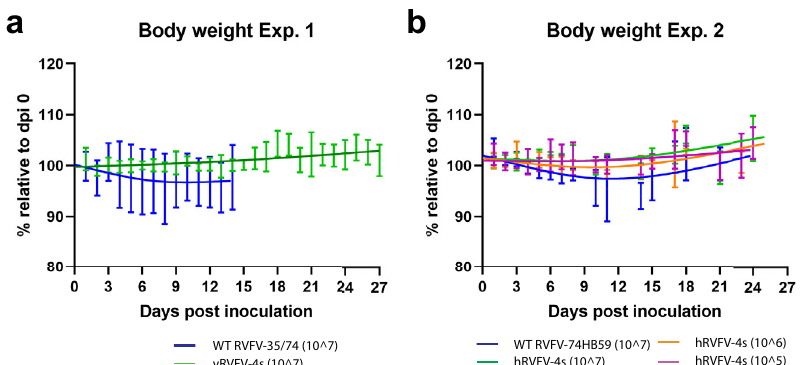
Fig. 2 RVFV-4s inoculated animals demonstrate no signi fi cant weight loss. Body weights relatively to day post inoculation (DPI) 0 measured in experiment 1 ( a ) and experiment 2 ( b ). Standard deviations are presented at each time point and spline trendlines were added (GraphPad Prism 9.0). No statistically signi fi cant differences were observed between